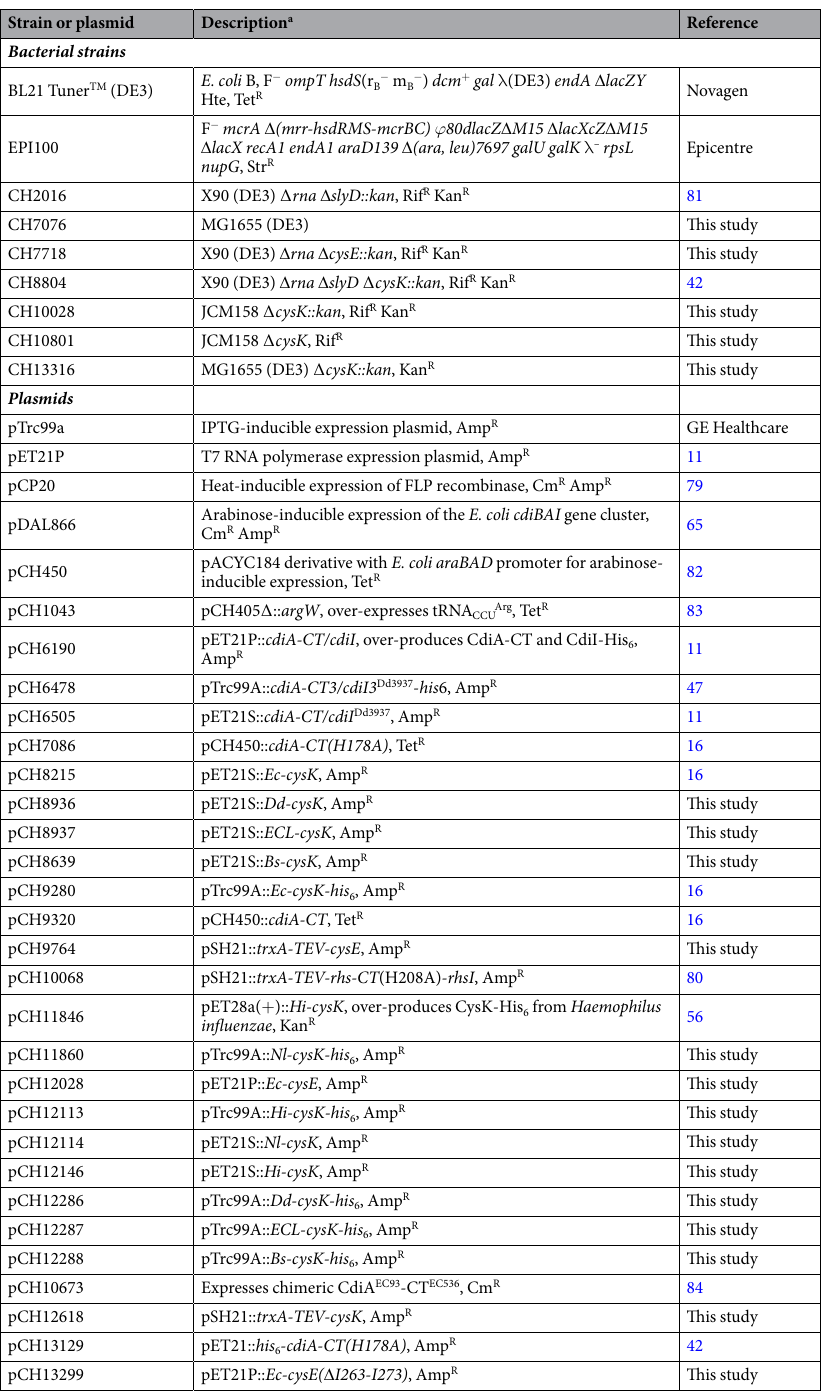
Table 1. Bacterial strains and plasmids. a Abbreviations: Amp R , ampicillin-resistant; Cm R , chloramphenicol- resistant; Kan R , kanamycin-resistant; Rif R , rifampicin-resistant; Str R , streptomycin-resistant; Tet R , tetracycline-